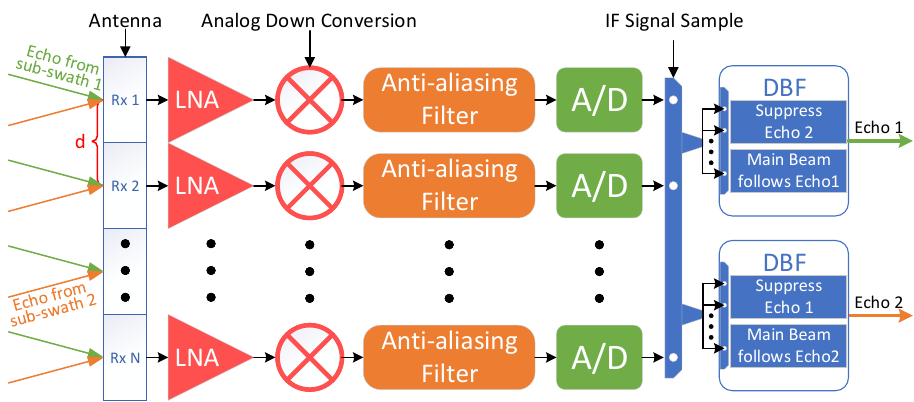
Figure 2. Block diagram of the top-level hardware structure of the STWE-SAR on